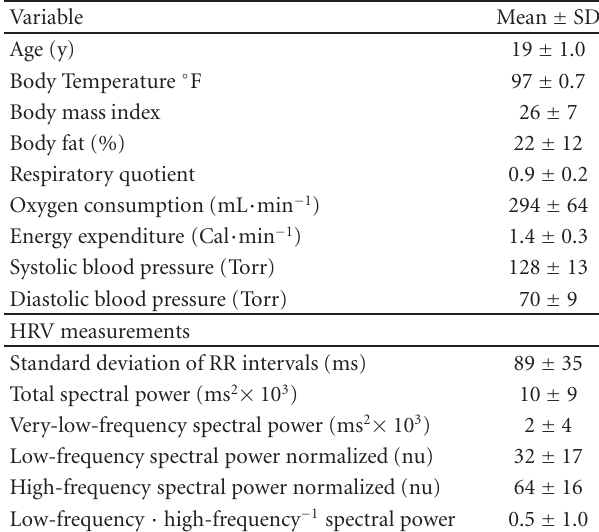
Table 1: Control measurements.